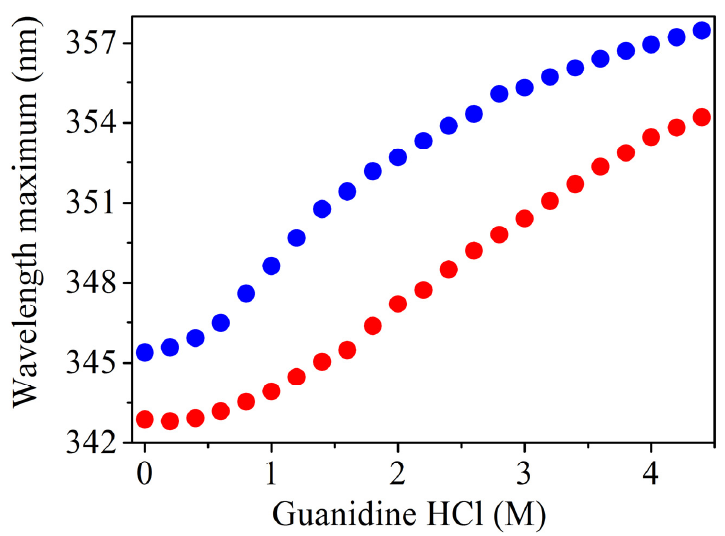
Figure 3. Chemical denaturation of Tm -MreB with guanidine hydrochloride. Tm -MreB can be denatured in high-salt (red) and even in salt-free (blue) environments. The emission spectra were fitted with the Gaussian function and the centre plotted as a function of the Gu-HCl concentration.